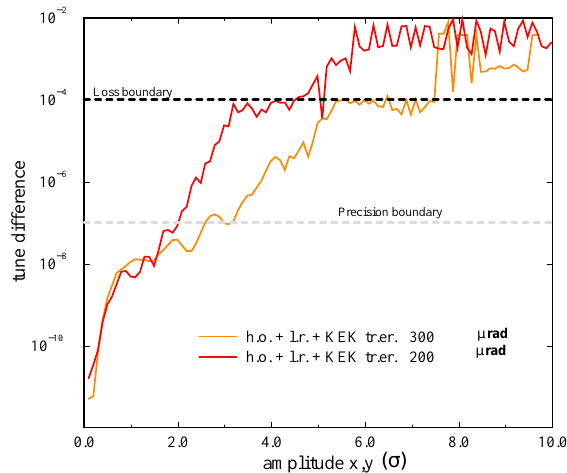
FIG. 16. (Color) The tune variation per 500 turns averaged over the initial x 2 y amplitude ratio, for two different crossing angles of 300 and 200 m